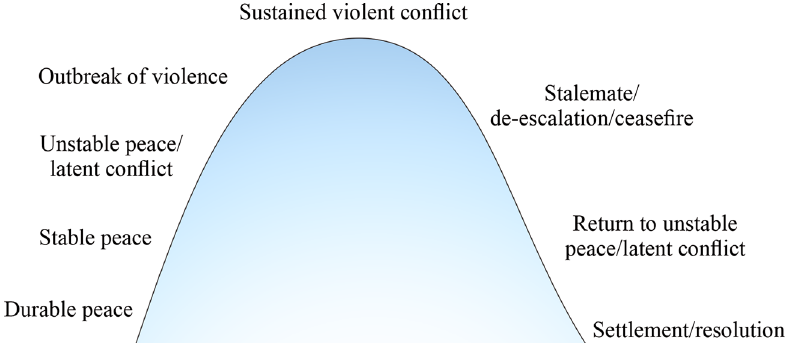
Figure 1: Phases of violent con fl ict [ 27 ]